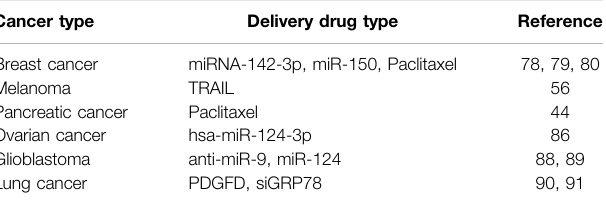
TABLE 2 | A summary of the various cargoes delivered by MSC-Exos for different oncology treatments. Cancer